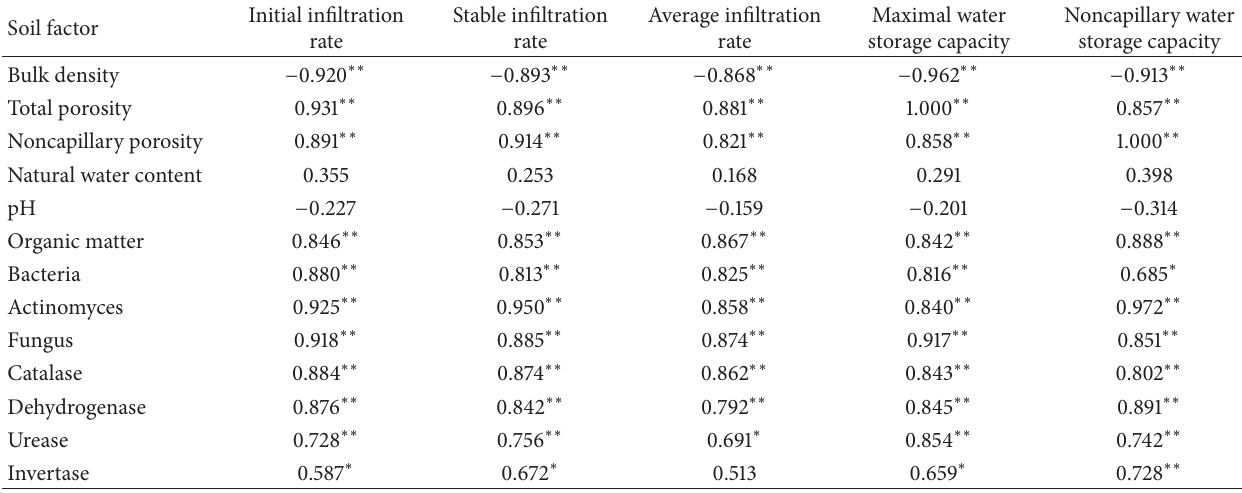
Table 5: Correlation analysis among soil infiltration rates, water storage capacities, and soil